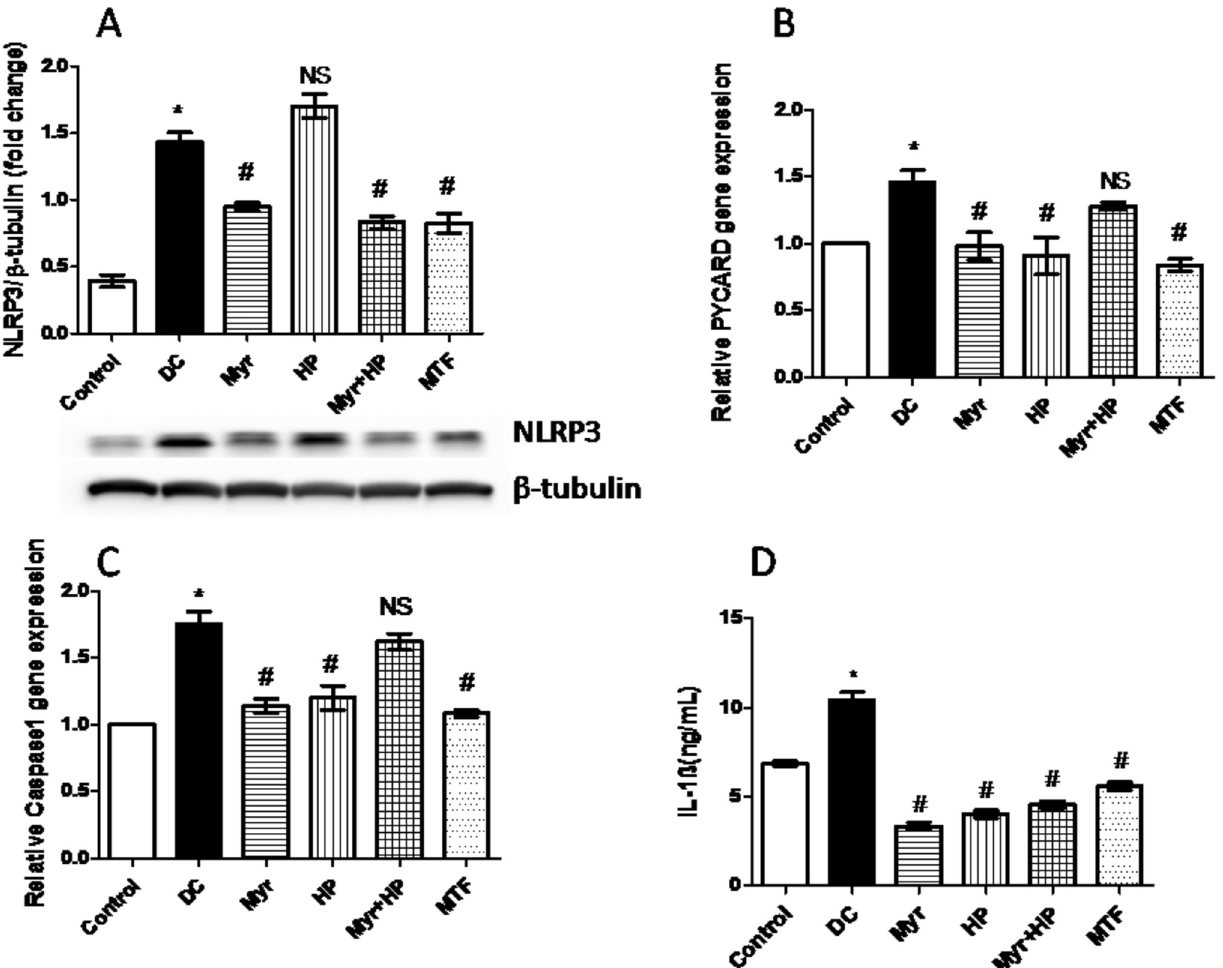
Fig 4. Analysis of modulation of proteins involved in the NLRP3 inflammasome. (A) Estimation of liver NLRP3 by immune-blot. Myr, HP, and MTF treatments were effective in reducing the level of NLRP3 protein. (B-C) Relative gene expression of PYCARD and Caspase-1 in the liver. Myr, HP, and MTF administration significantly reduced relative gene expressions of PYCARD and caspase-1. (D) Estimation of IL-1 β by specific ELISA kit. All the treatment molecules significantly reduced the IL-1 β levels compared to DC rats. Data are mean ± SD ( n = 6). � P < 0.05 when compared to control. # P < 0.05 when compared to DC and NS–not significant when compared to the DC